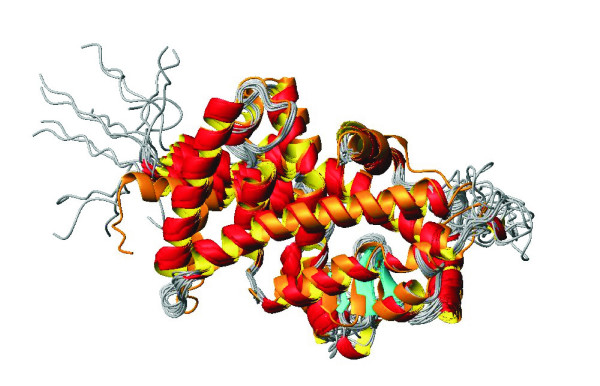
Comparison of the model structure of Ppar γ from human with the corresponding X-ray structure. Overall good agreement between the bundle of final model structures (helices in red and yellow, β-strands in blue and loops in grey) and the X-ray structure (orange) is obtained. Deviations are mainly seen in larger loop regions, the unstructured N-terminus and at the C-terminal end.